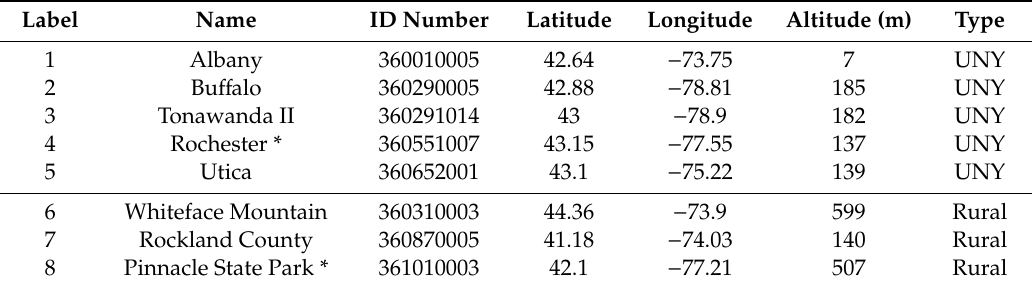
Figure 1. Topographic map with the PM 2.5 monitoring sites used in this study. Orange, blue and red circles are UNY, rural and NYC sites, respectively. Site labels are referred from Table 2. Table 2. List of PM 2.5 monitor sites in NYS used in this study. Site labels are referred to in Figure 1. Sites using Federal Equivalence Method (FEM) are marked with asterisks *. Sites 1–5, 6–8 and 9–21 are UNY, rural and NYC sites,